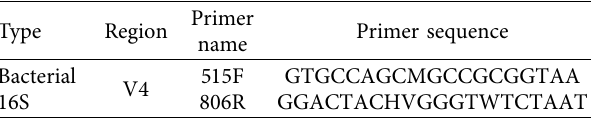
Table 2: Primers of the bacterial 16S rDNA V4